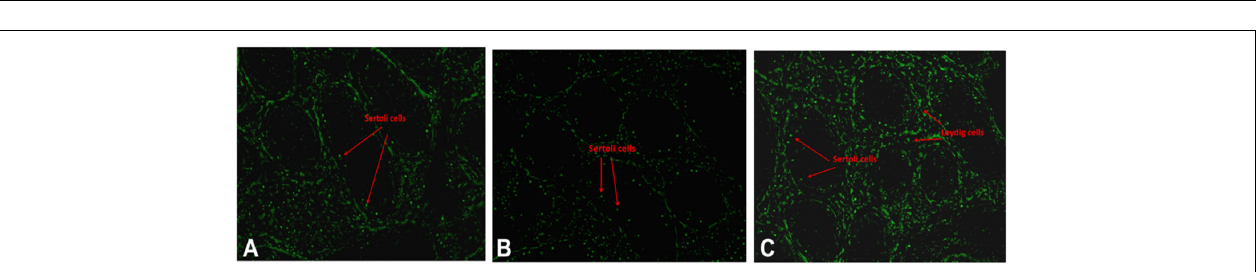
FIGURE 5 | Downregulated steroidogenesis related genes in crossbred testis and their biological process (Elliptical), molecular functions (octagonal) and pathway (triangle) (from Elango et al., 2020).